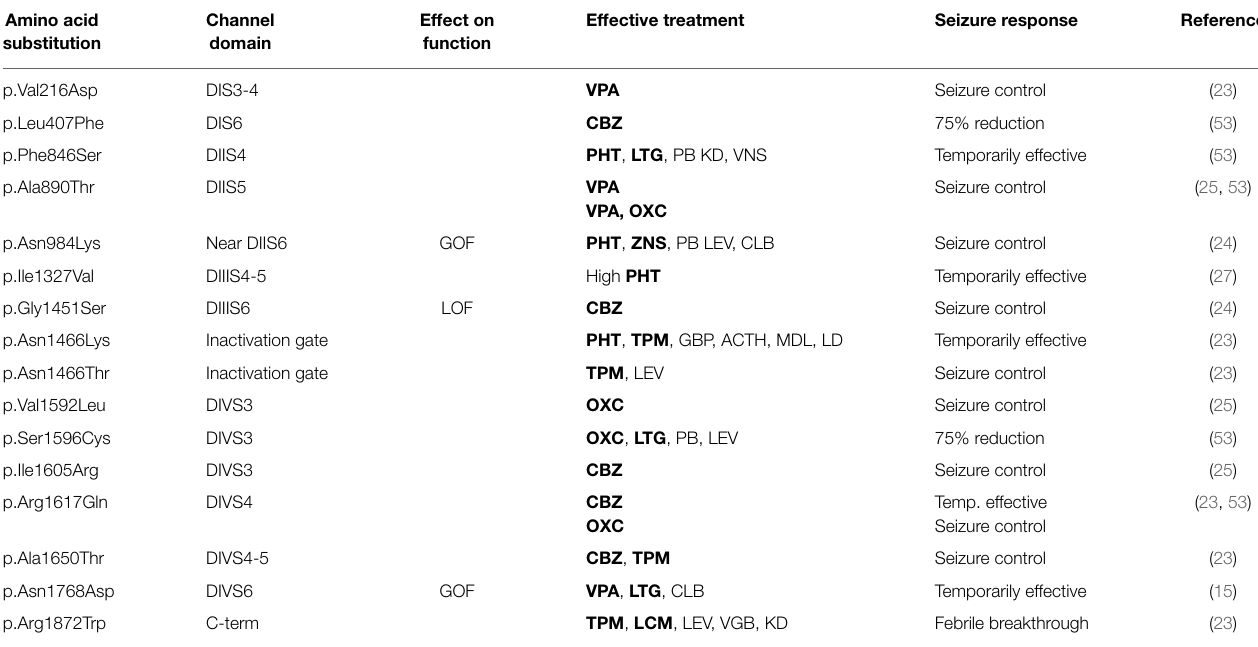
TABLE 1 | Reported drug response in epileptic encephalopathy due to SCN8A mutations .